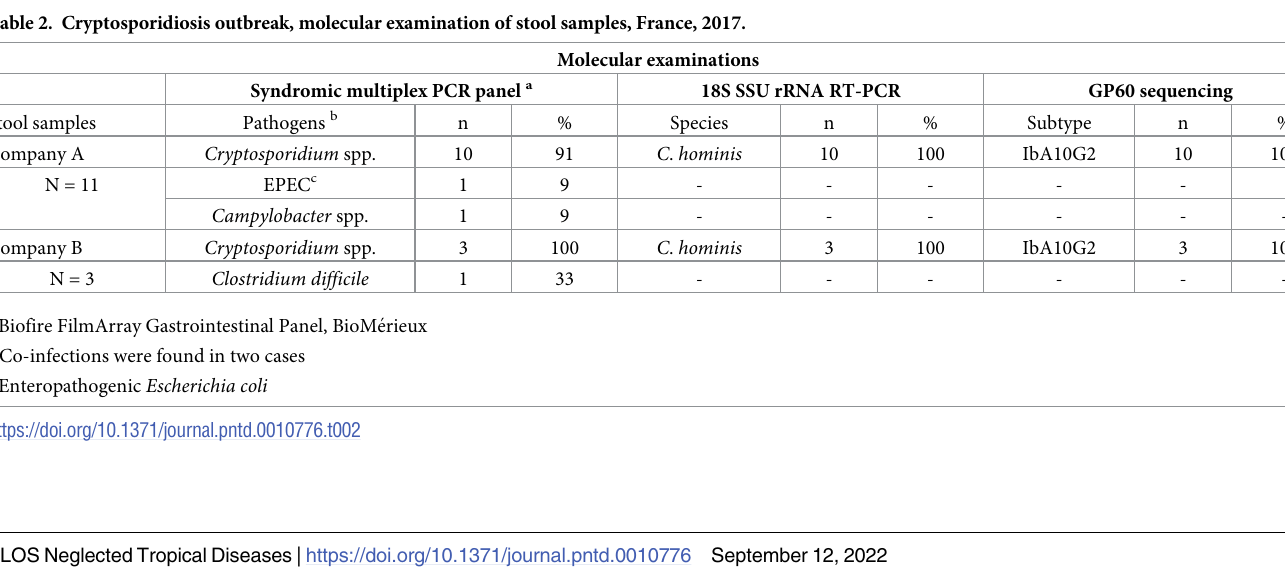
Table 2. Cryptosporidiosis outbreak, molecular examination of stool samples, France, 2017.